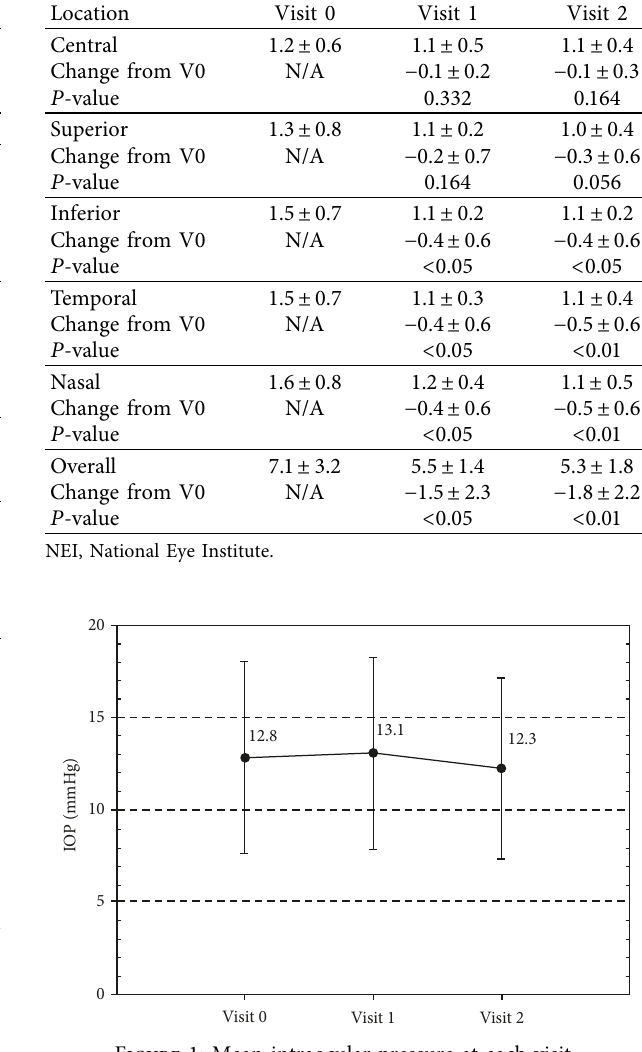
Table 1: Demographics and baseline characteristics of enrolled patients.